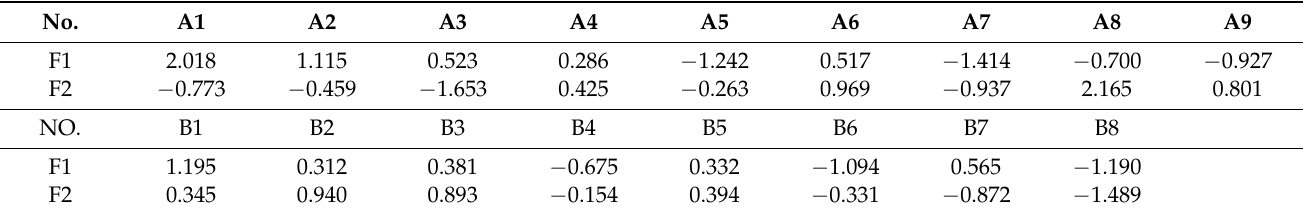
Table 4. Factor scores of different